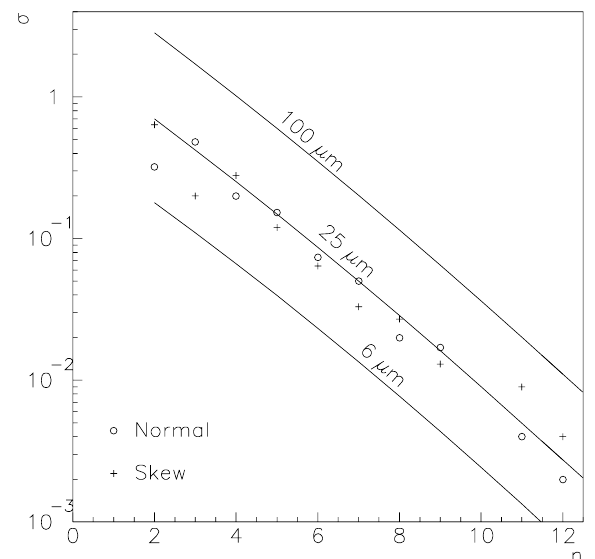
FIG. 3. rms of the multipoles along the axis for the LHC dipole prototype MBP2N2 (markers) and scaling law for different am- plitudes of random displacements d (solid